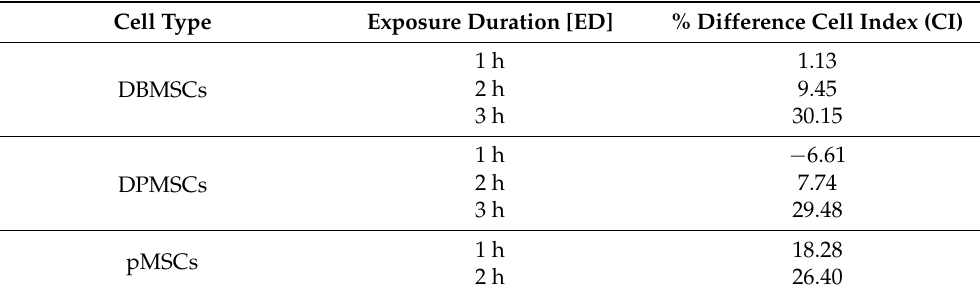
Figure 3. Cell proliferation assay in heat-stress models. Cells grown at 37 °C (C) and heat-exposed at 44 °C (For 1H, 2H, and 3H) were seeded in E-plate and monitored automatically. Cell Index (CI) values depicted here are 24 h post-heat stress and show statistically significant (** p < 0.05) reduction at 3 h exposure duration at 44 °C in DBMSCs and DPMSCs. In case of pMSCs although CI reduction of around 25% is observed, but it was not detected to be statistically significant. Table 1. Cell proliferation analysis in heat-stress models. Percentage Difference in Cell Index (CI) between heat-stressed cells and control cells (grown at 37 °C). These values were calculated over CI values estimated at 24 h post-heat stress.